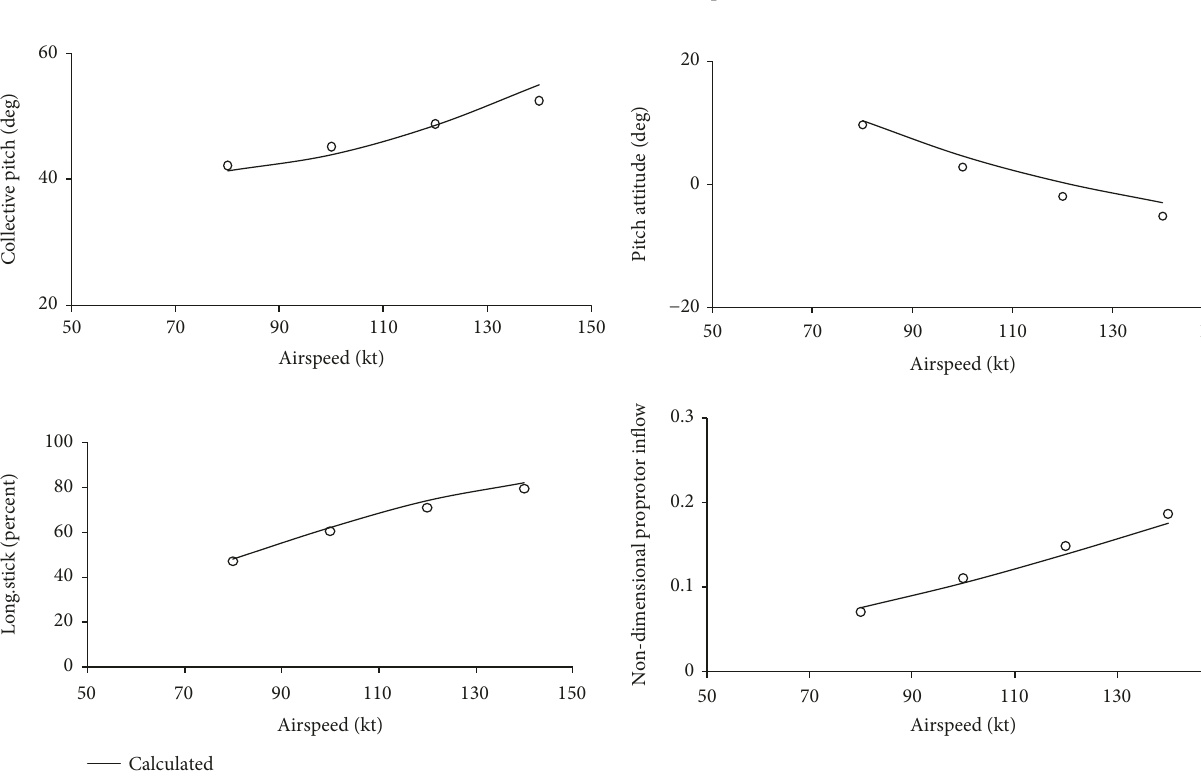
Figure 4: Trim results in helicopter mode.